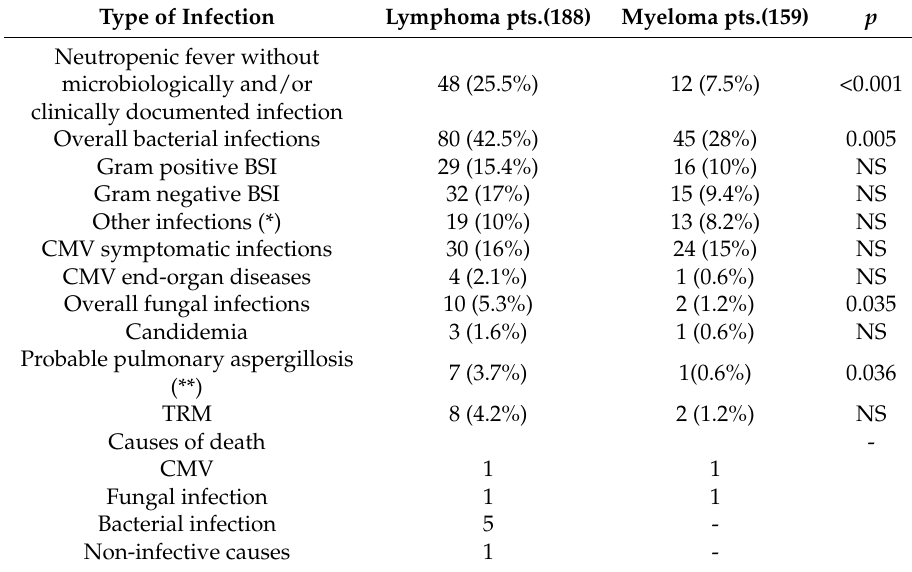
Table 2. Infection rates in our cohort of hematologic patients undergoing ASCT.